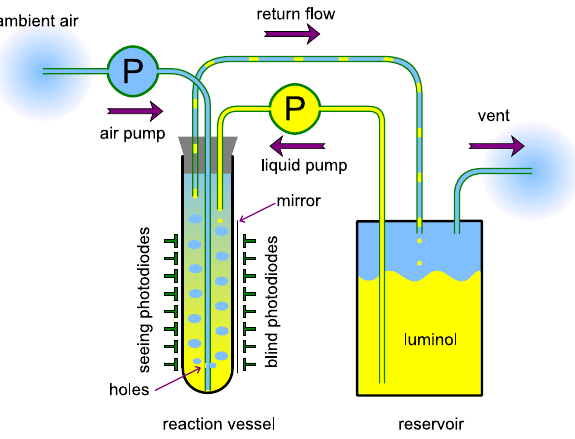
Fig. 2. The design of the NO 2 sonde. The liquid pump moves the luminol solution to the reaction vessel in the centre. The Teflon air pump forces the air into the reaction vessel. The NO 2 in the air re- acts with the luminol and the emitted photons are detected by an ar- ray of silicon photodiodes (the seeing photodiodes). An aluminum mirror is placed on the opposite site to reflect the emitted photons back to the seeing photodiodes. An identical array of photodiodes, the blind array, is mounted behind the aluminum foil to measure – and correct for – the effects discussed in Sect. 2.1. A copper wire is mounted in the reaction vessel to prevent electrostatic